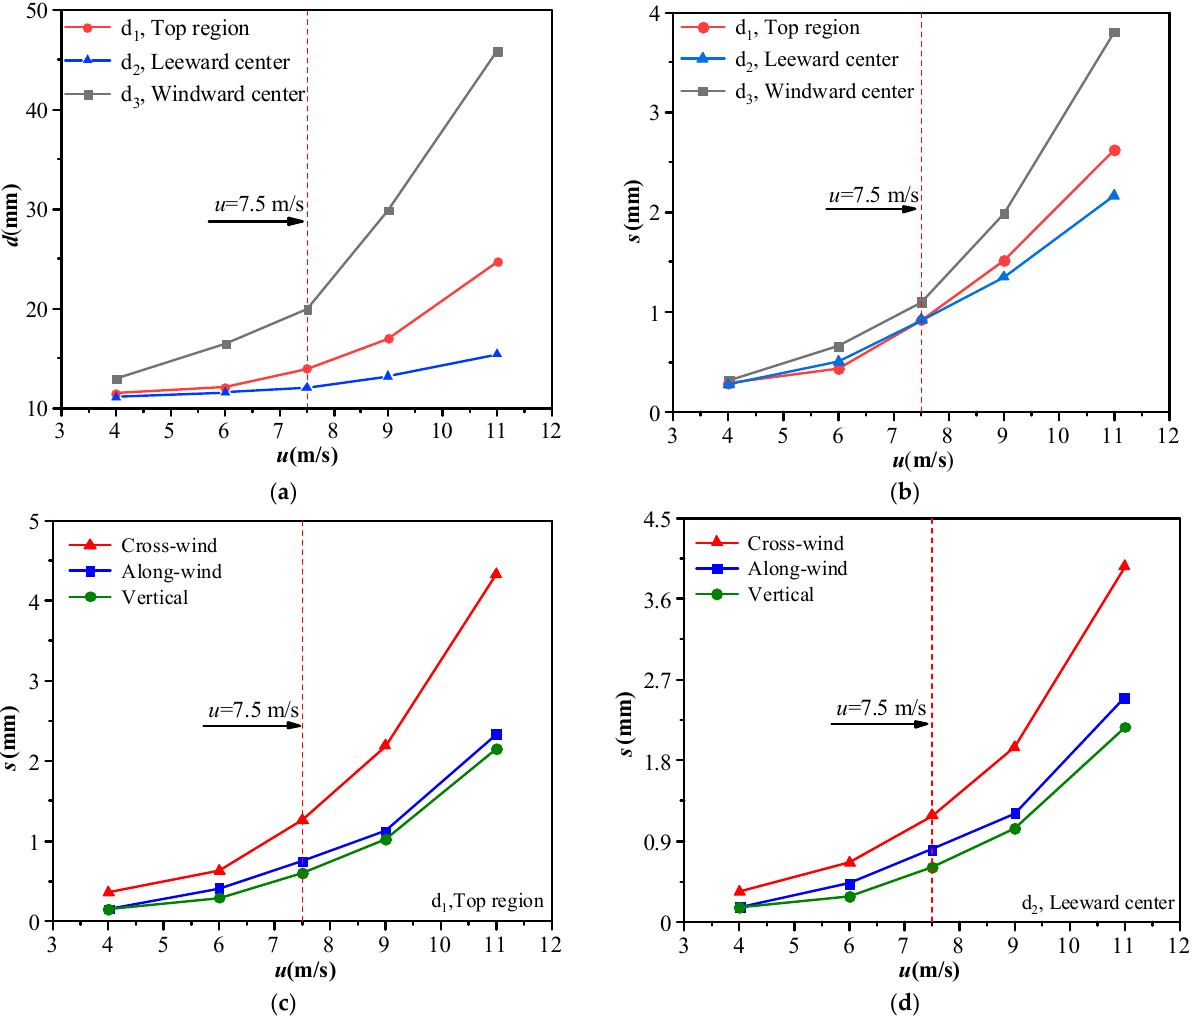
Figure 10. Time average deformation and standard deviation of displacement at different wind speeds: ( a ) time-averaged deformation, ( b ) overall standard deviation of displacement, ( c ) standard deviation of displacement of d 1 , and ( d ) standard deviation of displacement of d 2 .